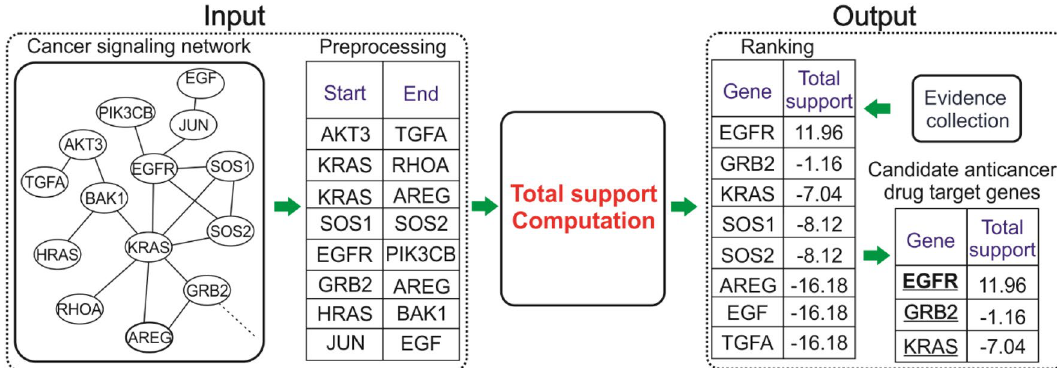
Figure 1. Process to identify anticancer drug target genes using an outside competitive dynamics model. From an input network, the process uses an algorithm based on the proposed model to compute the total support score of nodes in the network to each node for selecting the top three highest-ranking nodes, which are considered drug target genes as the